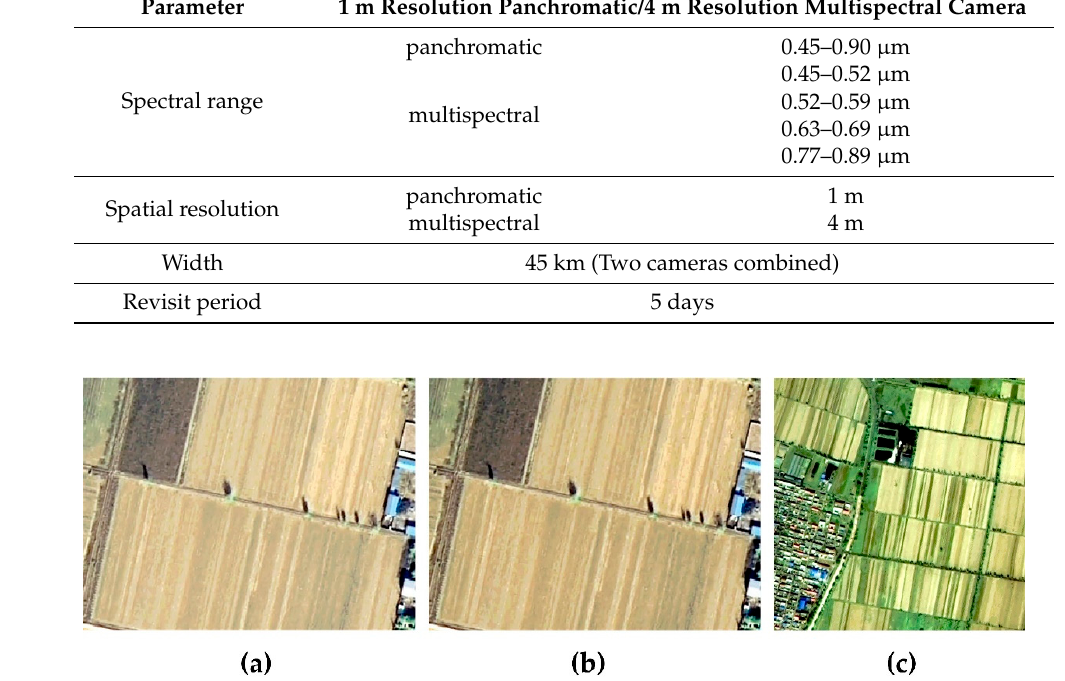
Figure 2. A subset of Gaofen-2 (GF-2) remote sensing images: ( a ) Original small image, ( b ) contrast-enhanced small image, and ( c ) larger image.